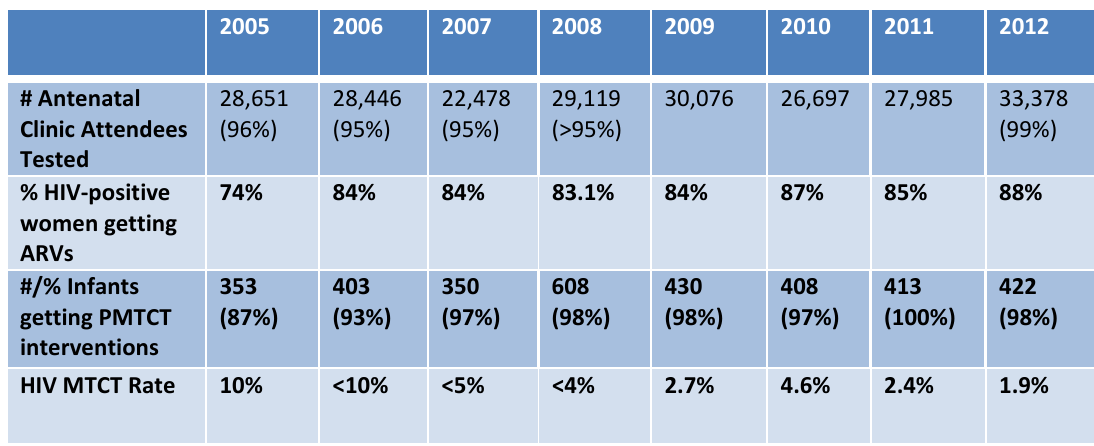
Table 5: Prevention of mother to child transmission programme data Data Sources: Ministry of Health, STATIN and